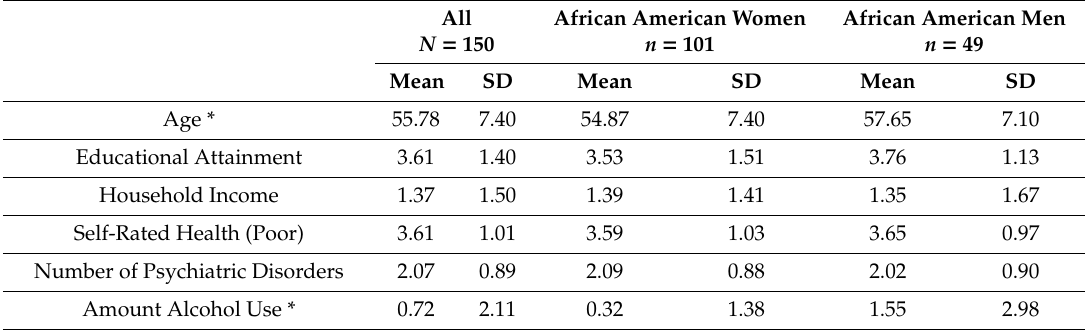
Table 1. Correlation between all the study variables in the pooled sample as well as African American men and women.